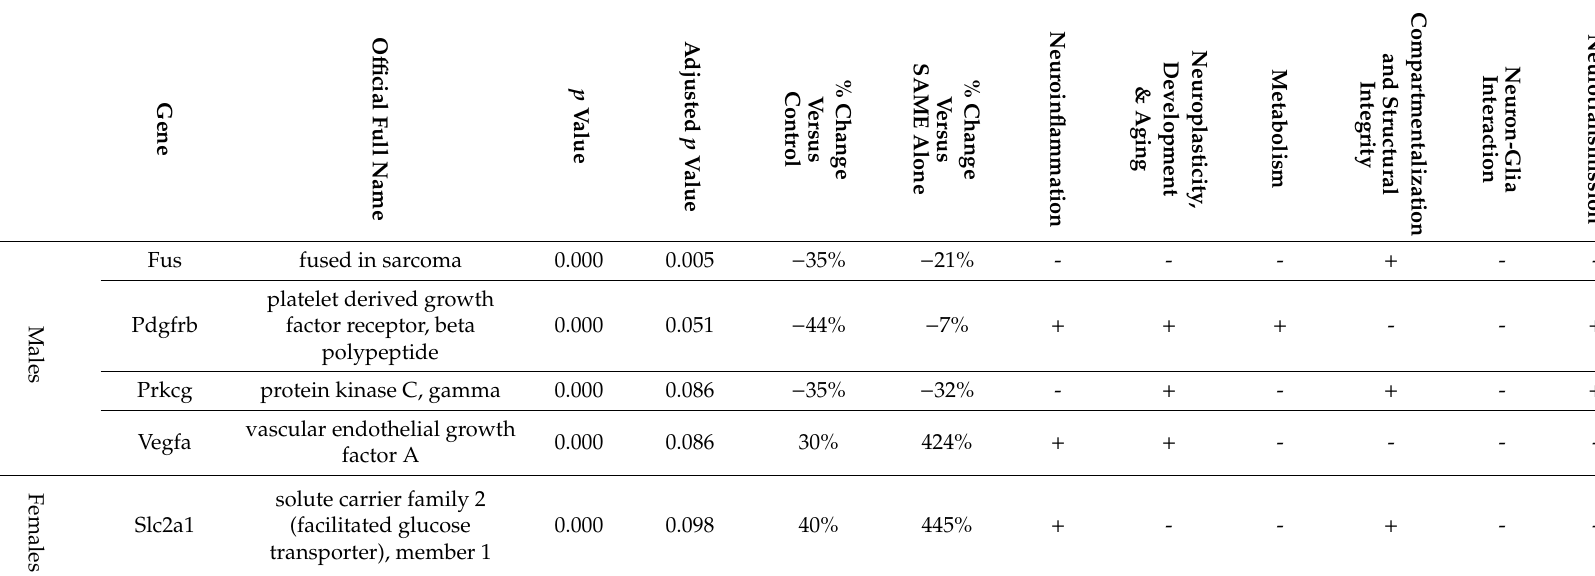
*The expression of Prkcg and Vegfa in males, and Slc2a1 in females was also significantly changed by SAMe alone. + and - are related to the belonging of the genes to a fundamental theme of